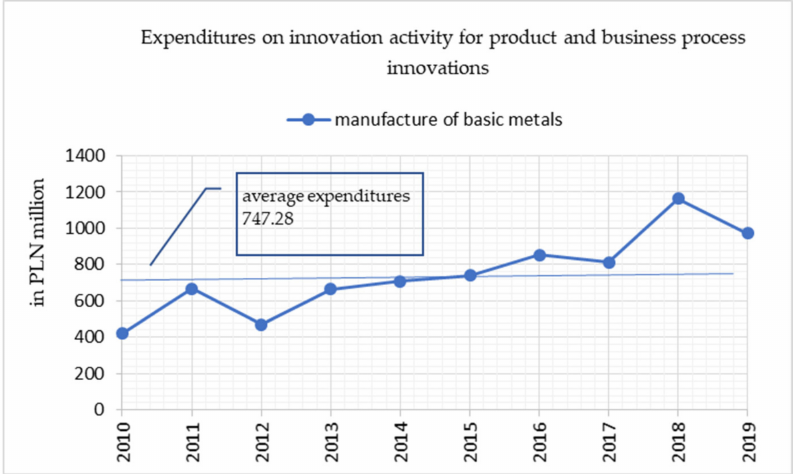
Figure 10. The amount of spending on innovation activity for product and business process in- novations in the manufacture of basic metals in Poland. Source: adapted with permission from Refs. [101–109].